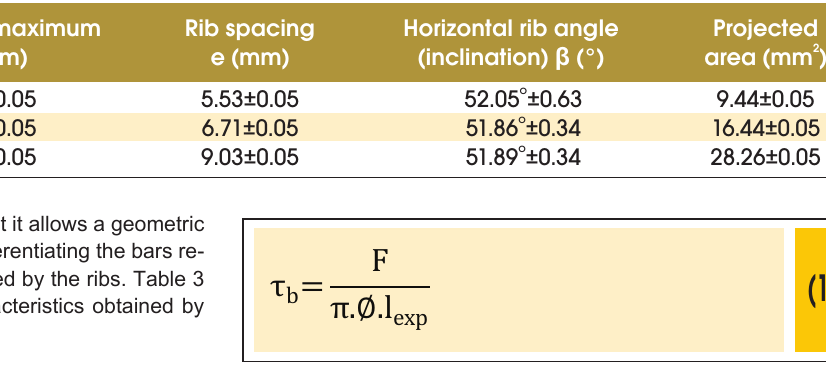
Table 3 – Geometric characteristics of the steel bar ribs